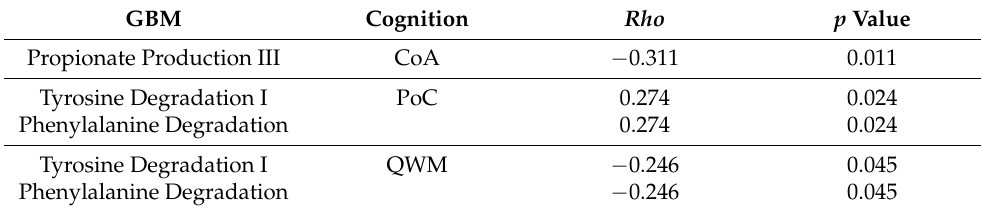
Table 6. Spearman correlation between gut microbial function and